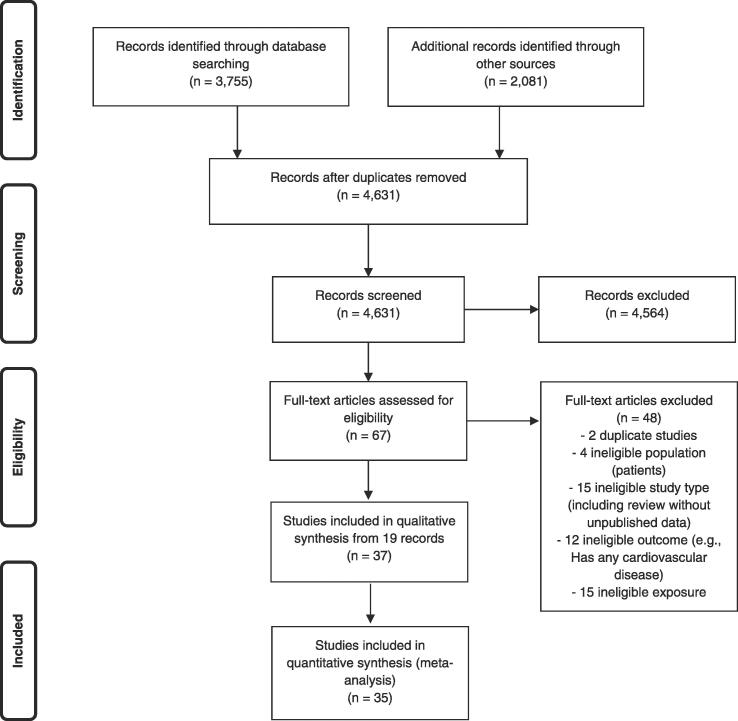
Flow diagram of study selection.